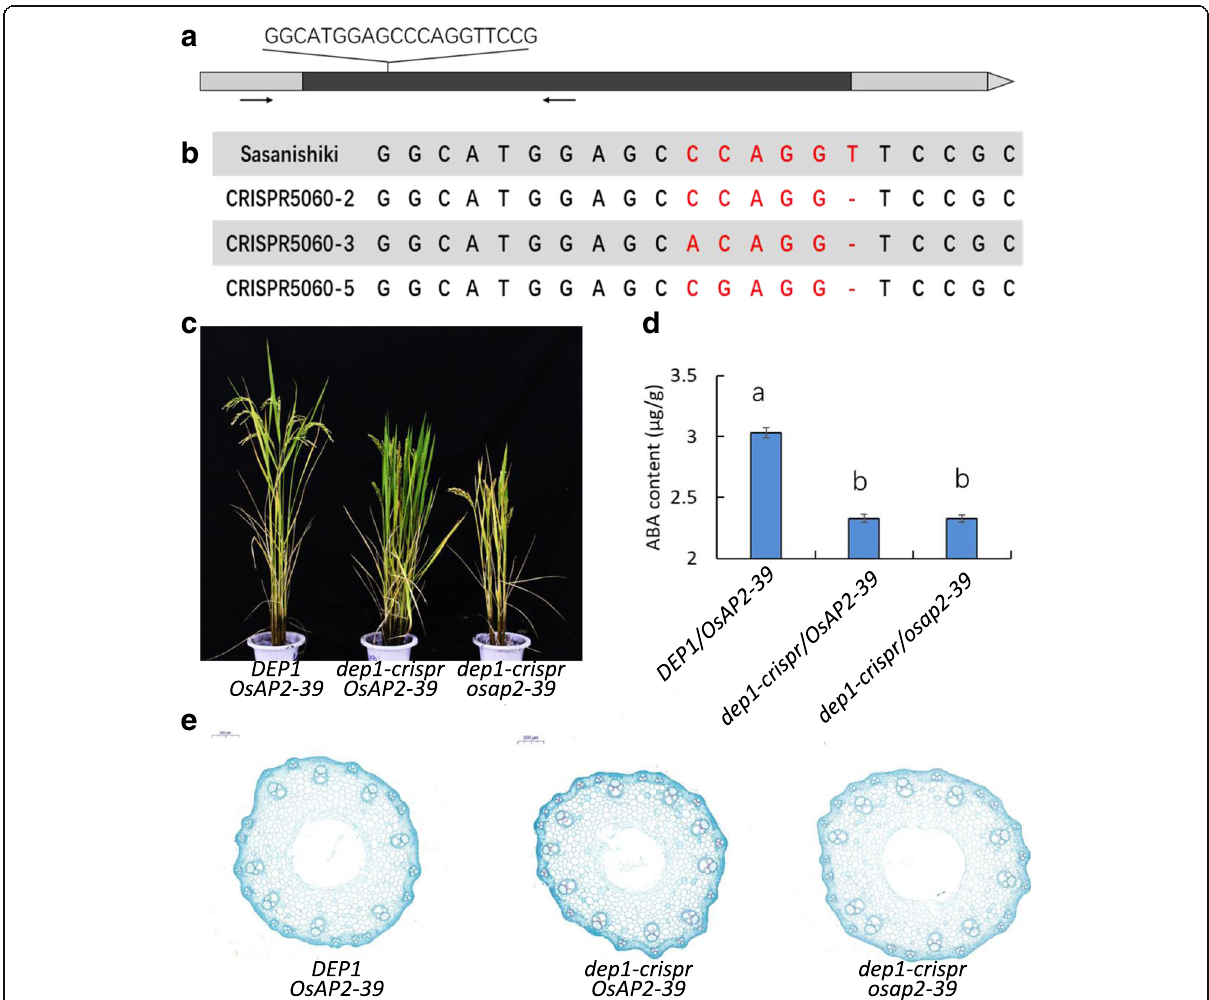
Fig. 5 The endogenous ABA level and vascular bundles of WT and CRISPR/Cas9-induced DEP1 mutant lines. a Schematic map of the genomic region of OsPA2 – 39 and the sgRNA target site and the sequences of the mutant lines. The arrows show the position of the PCR primers used for mutation detection. b The sequences of the mutant lines. c The WT plant and CRISPR/Cas9 induced DEP1 mutant line. d The endogenous ABA levels of WT and mutant lines. e The difference in vascular bundles between WT plants and the CRISPR/Cas9 induced DEP1 mutant